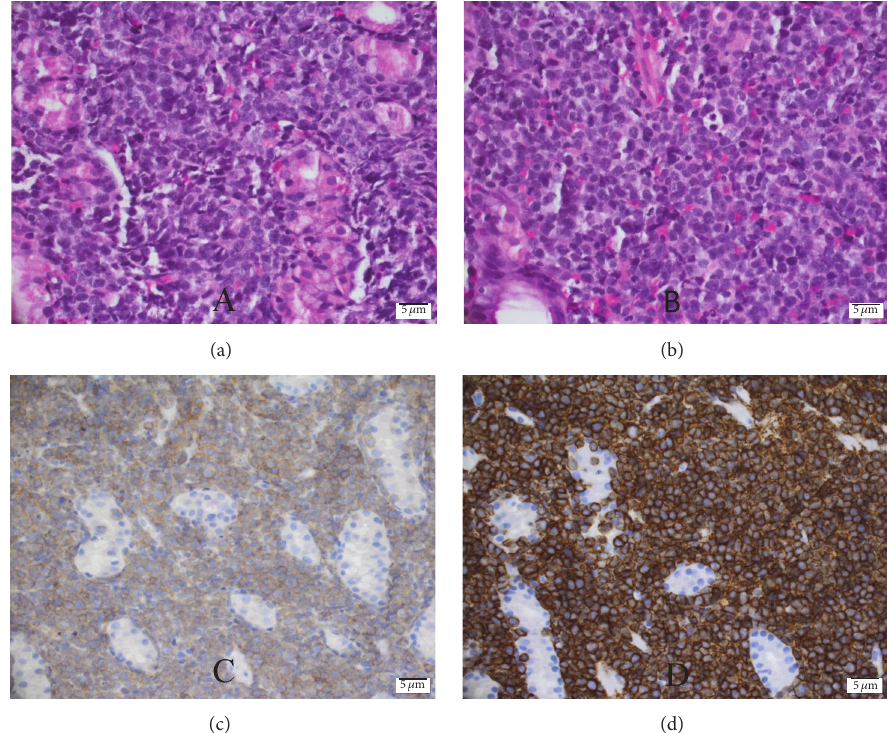
Figure 2: Histopathology of Burkitt’s lymphoma cells from duodenal biopsy showing moderately enlarged hyperchromatic nuclei with no prominent nucleoli and starry sky appearance under the microscope with hematoxylin and eosin stain (a & b), CD10 positivity (c), and CD 20 positivity